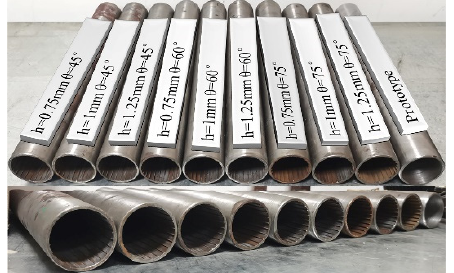
Figure 4. Experimental test specimens.